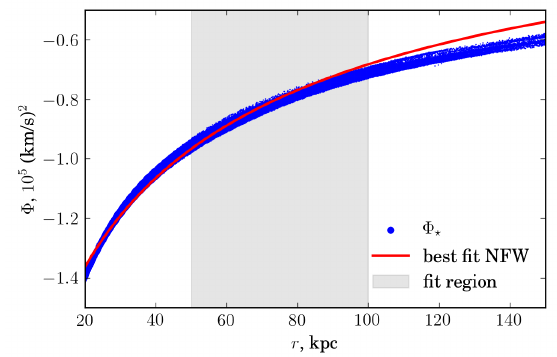
Figure 3. Gravitational potential Φ ∗ of star particles in the simulated galaxy calculated directly from the simulation (blue) as a function of radius r , with the best direct fit of the NFW functional form (red) over the range shaded in gray. The density of stars is higher at smaller r within the range being fit, so agreement at smaller r is prioritized (consistent with the behavior of the action-space fitting